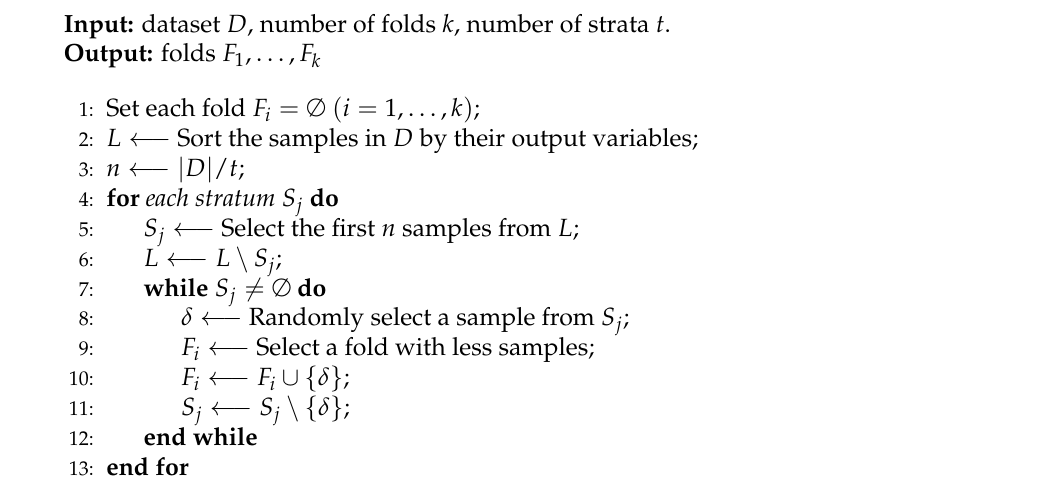
Algorithm 3 t -stratified cross-validation ( SCV t ).